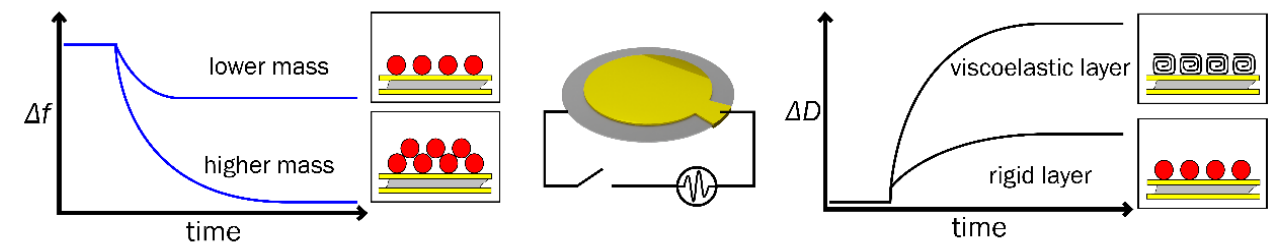
Figure 3. Schematic representation of QCM-D measurement and operating principle. Δf — time depended change in frequency, ΔD — time depended change in energy dissipation.